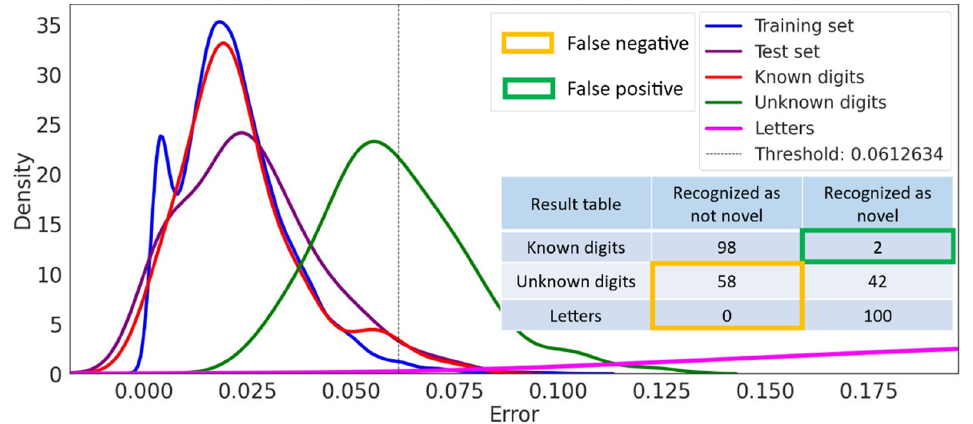
Figure 9. First improvement of novelty detection with a semantic topology.